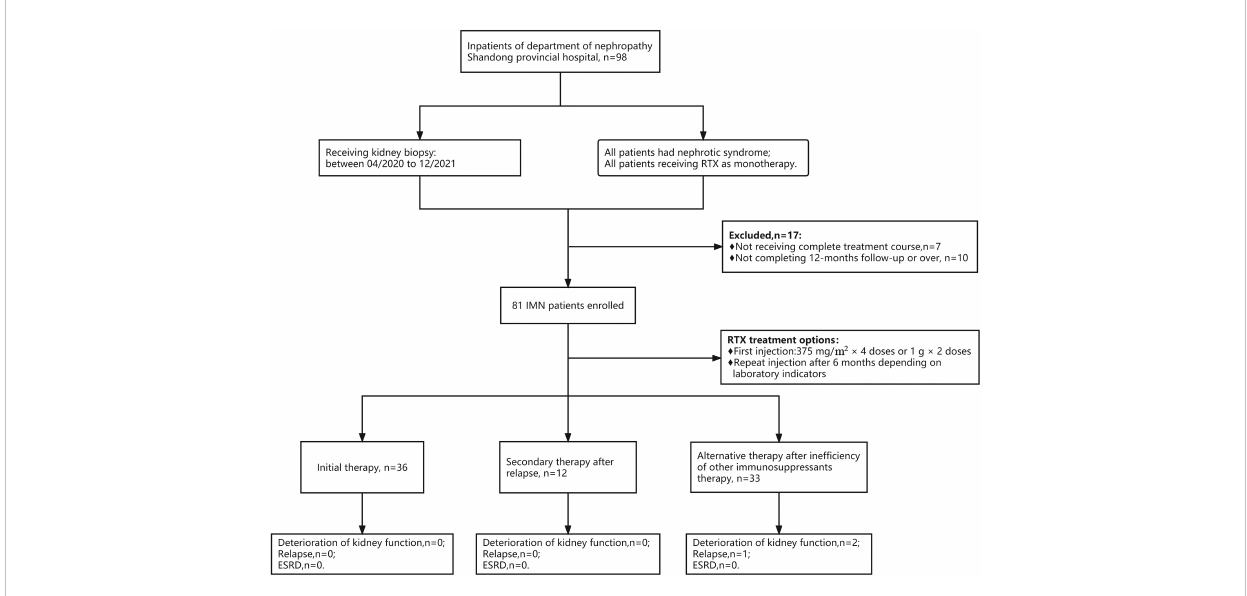
FIGURE 1 Flow chart of selection for patients with PMN receiving rituximab therapy. A total of 81 PMN patients were enrolled, with 36 patients receiving rituximab as the initial therapy, 12 receiving RTX as a secondary therapy after relapse, and 33 receiving RTX as an alternative therapy after failure of other immunosuppressant therapy. During follow-up, 2 patients had worsening renal function, and 1 patient relapsed, both from the ineffective group. No patients entered ESKD.